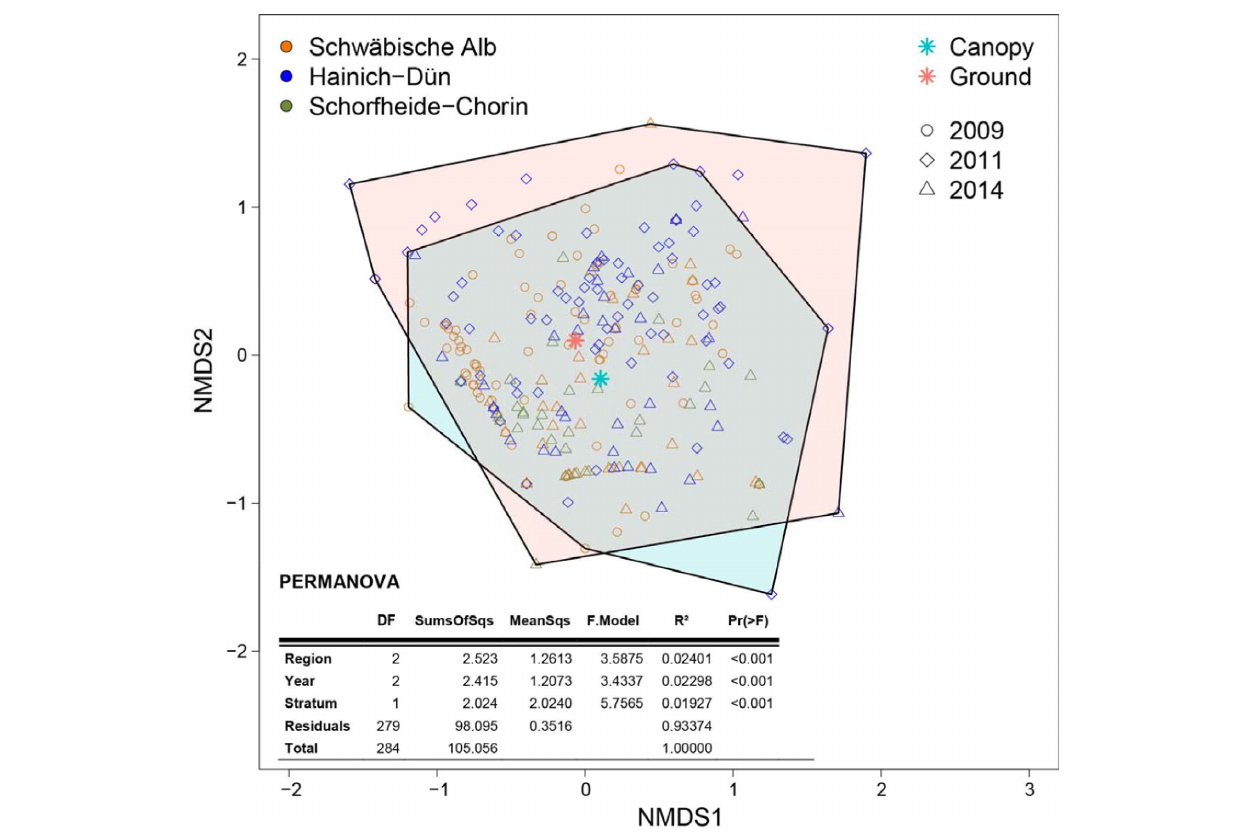
FIGURE 1 | Non-metric multidimensional scaling (NMDS) based on Bray-Curtis distances of insect communities in water-filled tree holes sampled in the canopy and near the ground in three regions of Germany between 2009 and 2014 (stress = 0.142). Colored hulls indicate the space covered by the communities in the canopy (at ≥ 2 m height; blue) and near the ground (at < 2 m; red). The table shows the results of a PERMANOVA, testing for differences in community composition between region, year and height stratum. Please note that the R 2 value for stratum shows the effect strength after controlling for differences between individual regions and between individual years (Type I sum of squares,